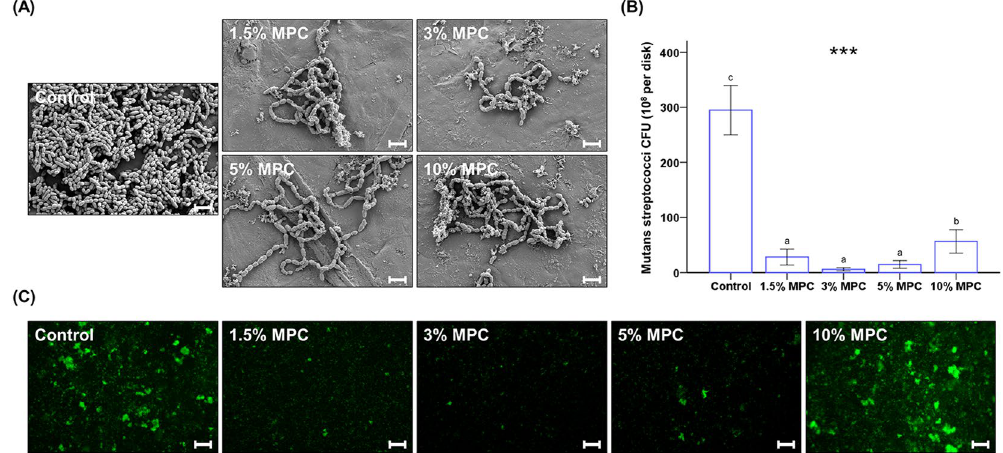
Figure 3. Qualitative scanning electron images of S. mutans cells attached to the surfaces of control and experimental groups at a magnification of 5,000 × ( A ). Scale bar is 2 µ m. Colony-forming unit (CFU) counts derived from S. mutans cells attached on the surfaces of control and MPC-LCFV ( B ). Different letters above bars indicate significant differences. *** P < 0.001 for comparisons between LCFV with different concentrations of MPC. Representative live/dead staining images of S. mutans cells attached on the surfaces of control and experimental groups ( C ). Scale bar is 100 µ m.